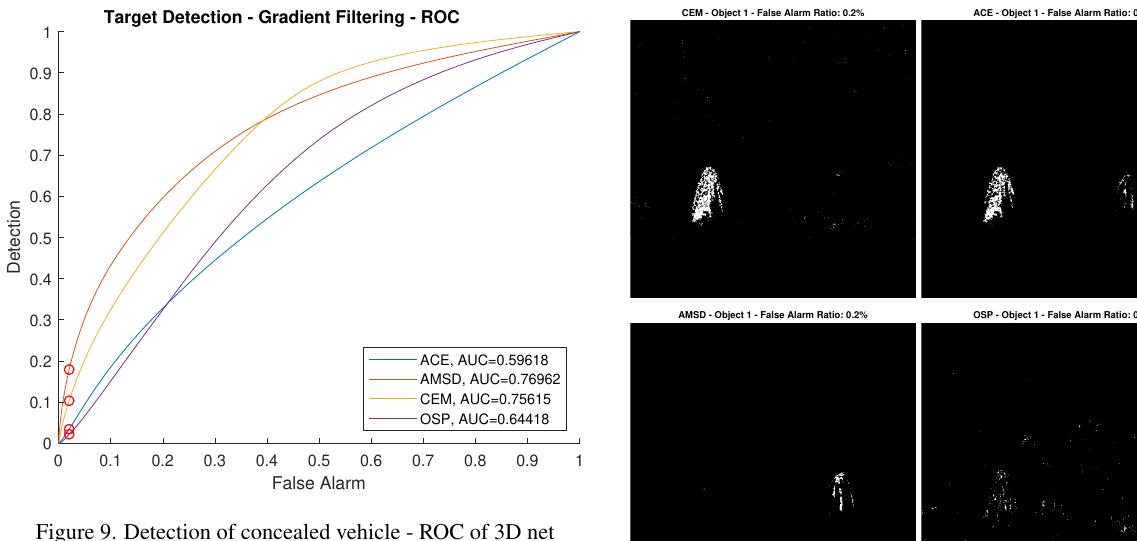
Figure 9. Detection of concealed vehicle - ROC of 3D net